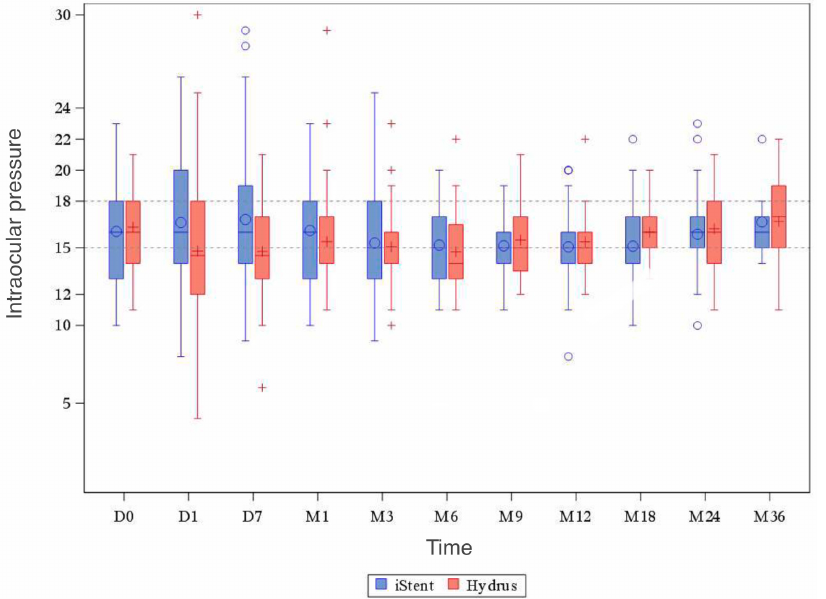
Figure 2. IOP values for the iStent and Hydrus methods in individual periods after surgery.